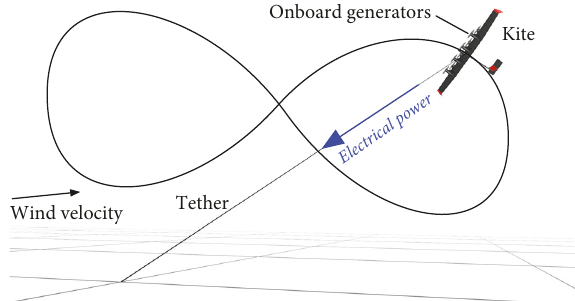
Figure 1: Illustration of “drag power.”